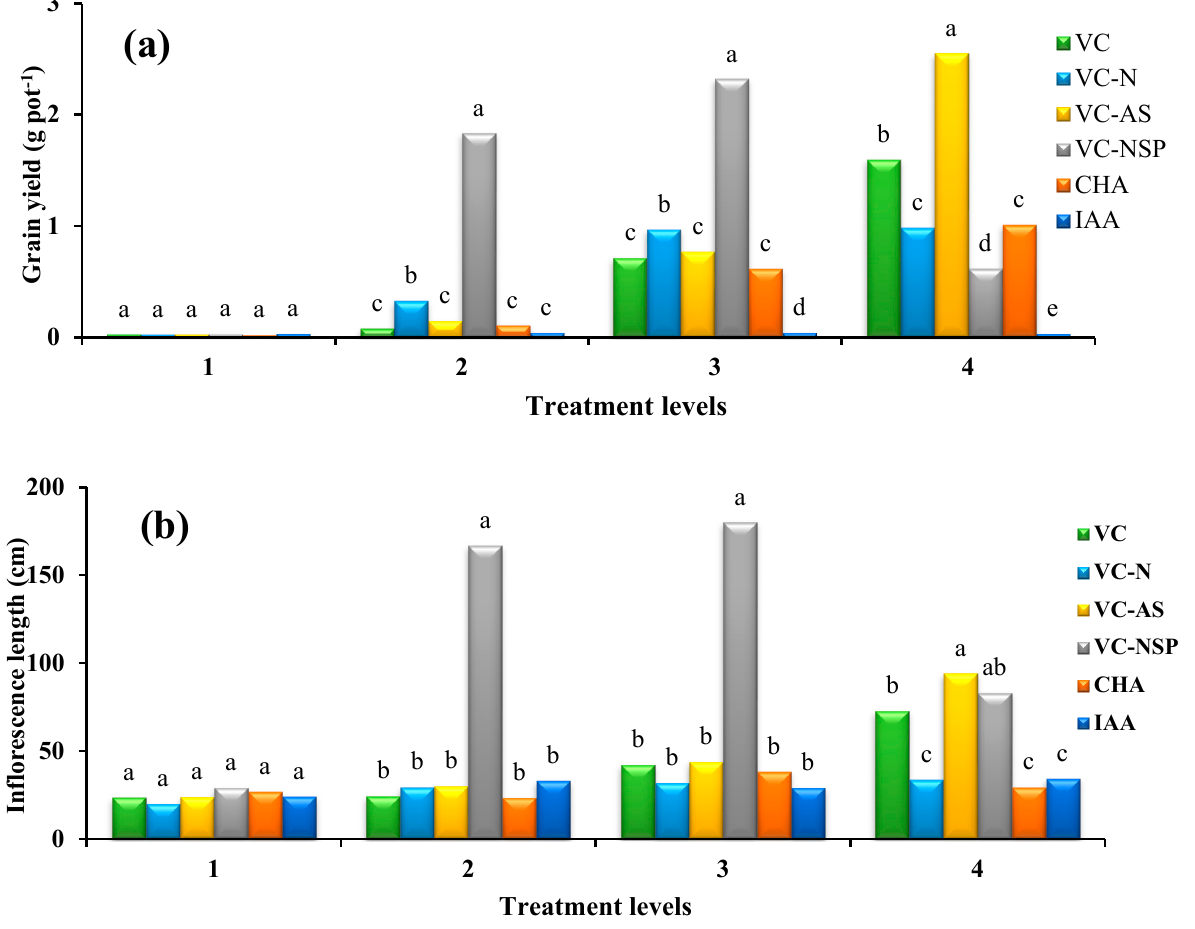
Figure 5. Comparison of average soil application of experimental treatments on Grain yield ( a ) and Inflorescence length ( b ) at treatment levels (levels 1, 2, 3 and 4 for VC, VC-N, VC-AS and VC-NSP treatments of 0, 1, 2 and 3% VC, 0, 200, 400 and 600 mg of CHA per kg of soil and 0, 10 − 6 , 10 − 5 and 10 − 4 molar IAA). Different letters in each figure show significant difference at p ≤ 0.05 by Duncan multiple range test. VC, VC without enrichment; VC-N, VC enriched with 1% nitrogen; VC-NSP, VC enriched with 1% nitrogen, 1% sulfur, and 1% phosphorus; VC-AS, VC enriched with Azotobacter chroococcum (21Az) + Pseudomonas fluorescens (Ps 59); CHA, Commercial humic acid; IAA, Indole-3-acetic acid.